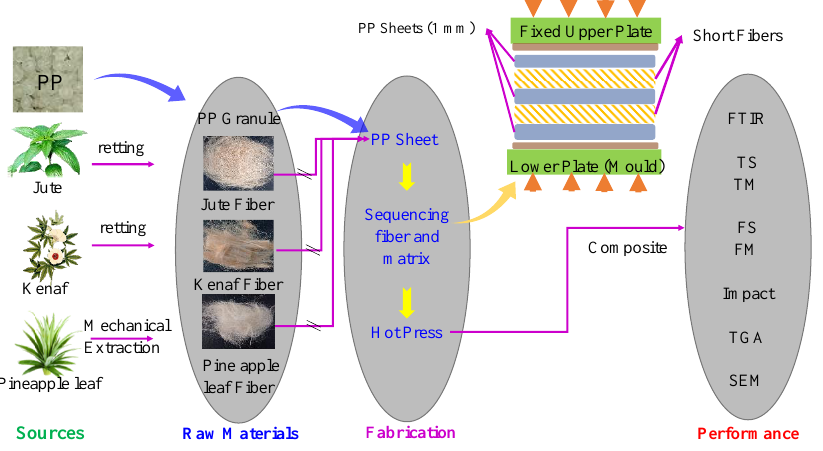
Figure 2. Schematic diagram of experimental procedure.